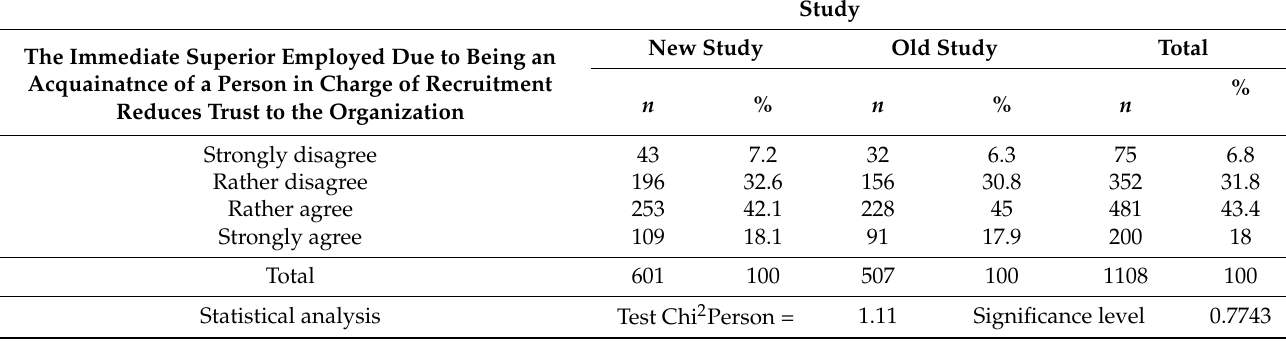
Table 19. Statistical analysis of the assessment of the impact of the immediate superior of the employed person “due to the acquaintance” with the person in charge of the recruitment on trust in the company depending on the date of the